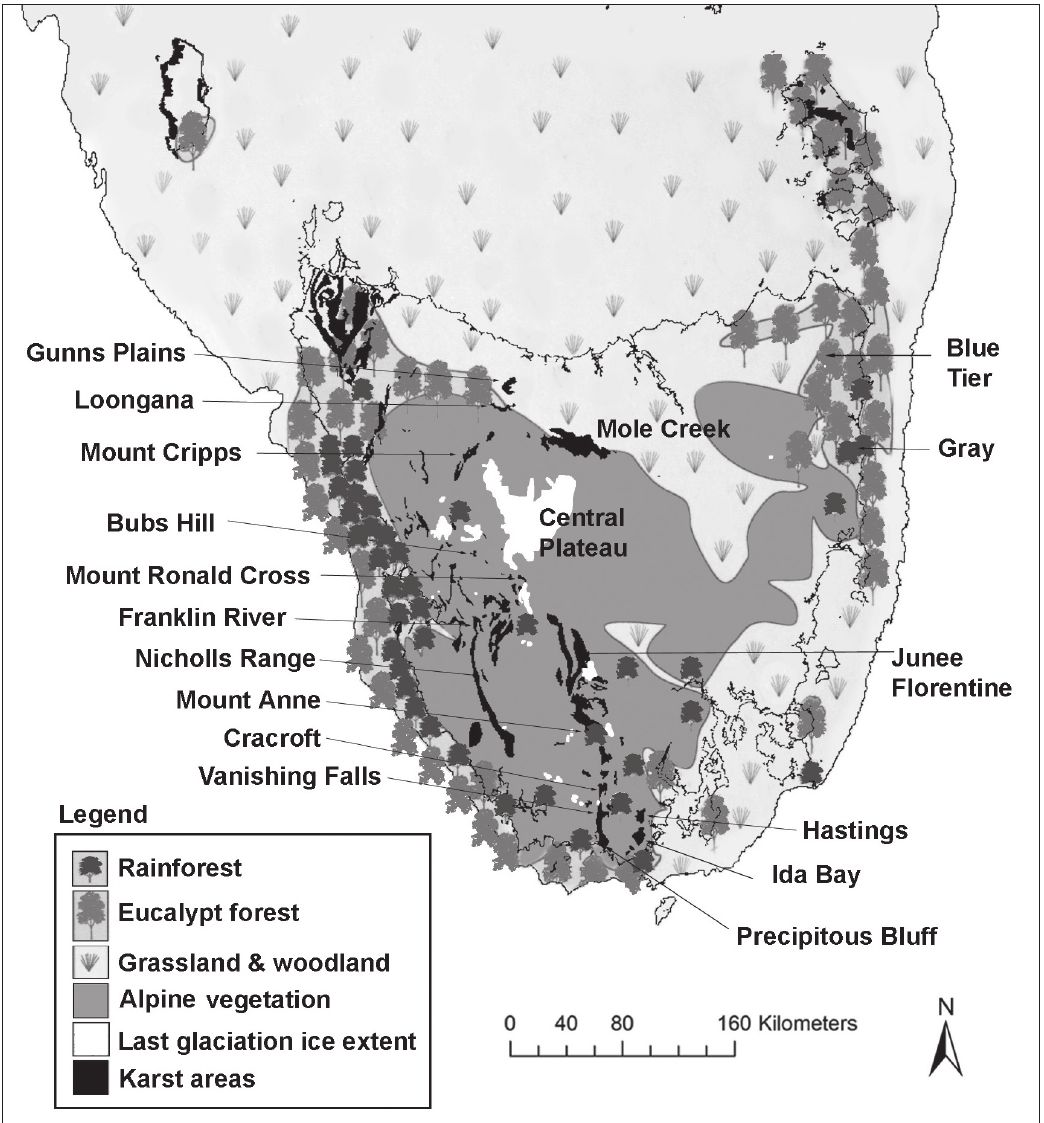
Map 21 - Tasmania showing modelled distribution of vegetation types at the height of Last Glacial (based on Kirkpatrick & Fowler 1998) and karst areas. Modified from map prepared by Dr Greg Jordan (University of Tasmania). Karst and ice data provided cour- tesy of the Department of Industry and Water,